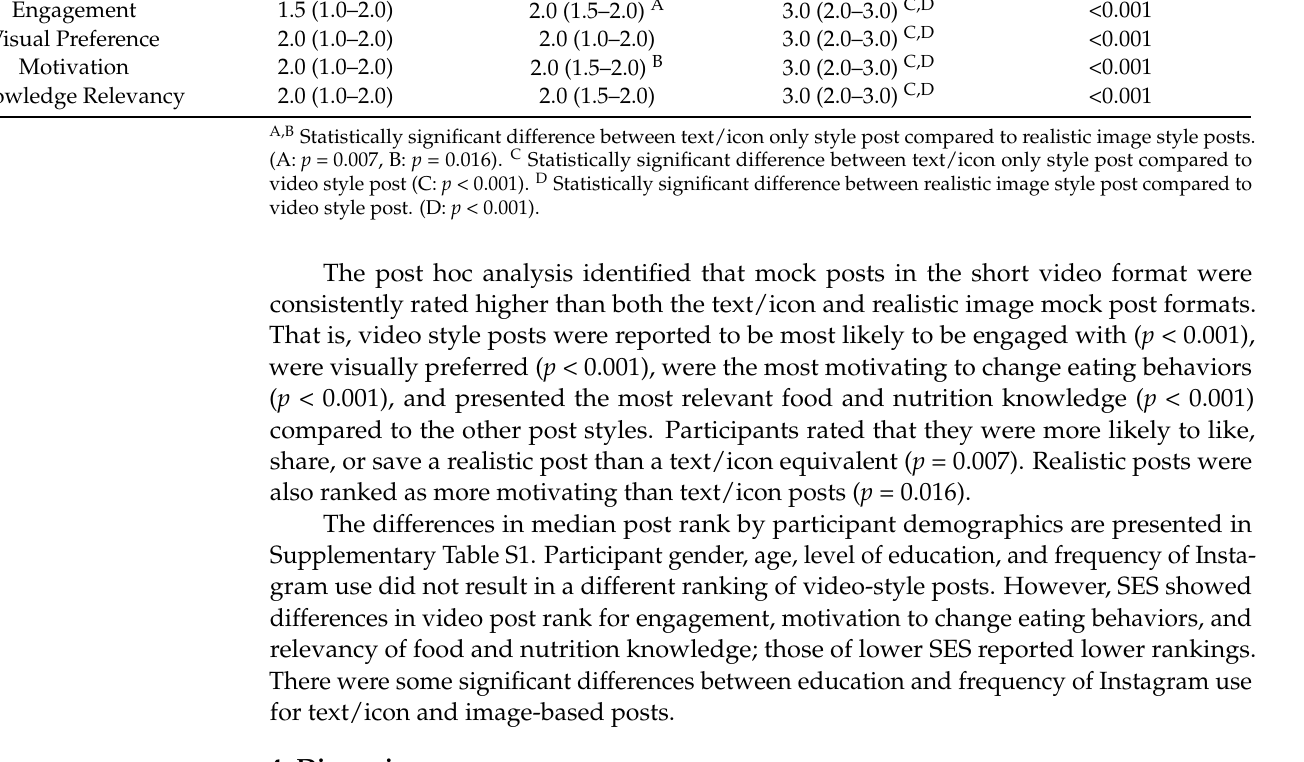
Supplementary Table S1. Participant gender, age, level of education, and frequency of